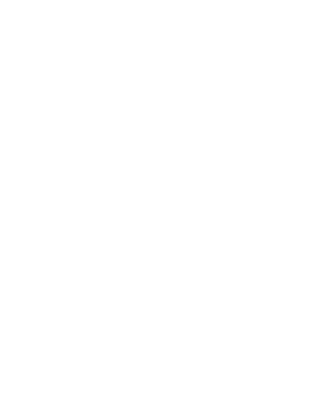
FIGURE 5 Funnel plot of asymmetry test of the publication bias of